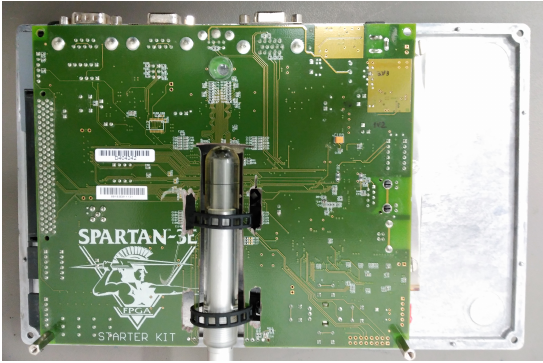
Figure 4. PCB customized to carry out the dosimetry measurements with the reference point of the ionization chamber placed exactly in the position of the device under test